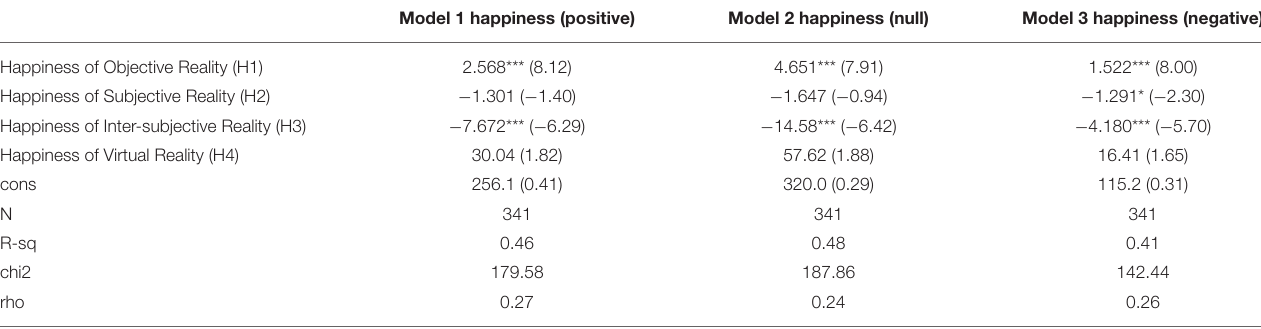
TABLE 5 | Regression models of public happiness from “Blogs-Comments” over